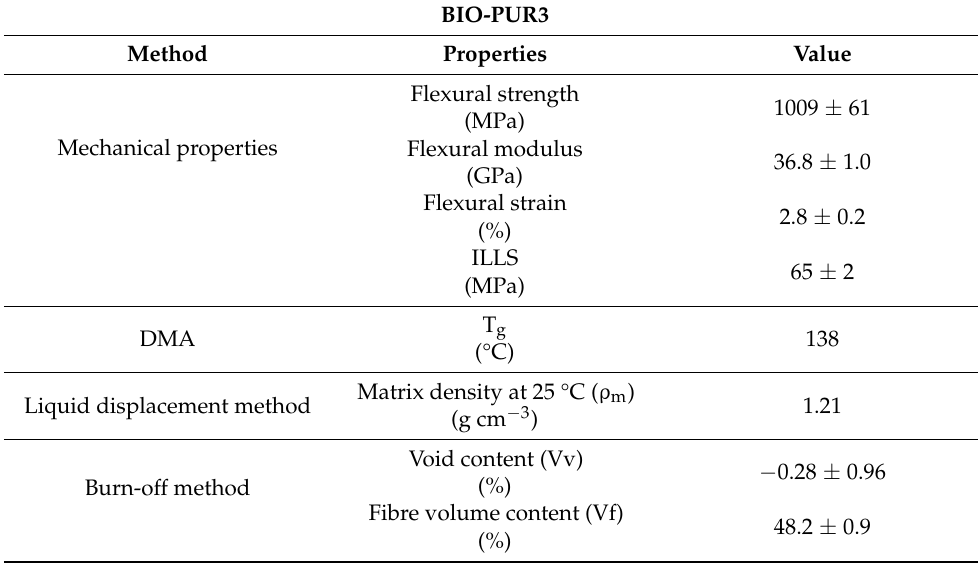
Table 4. Final properties of BIO-PUR-based composite.